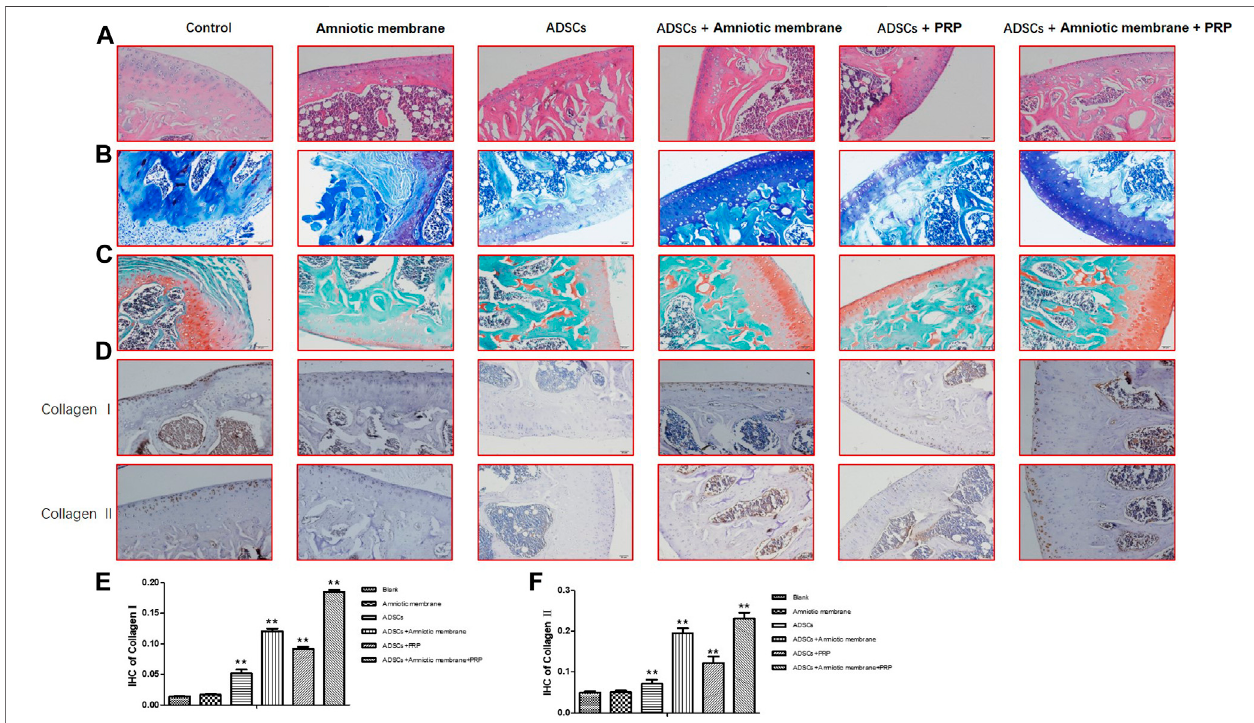
FIGURE 6 | The combination of amniotic membrane and PRP scaffolds effectively induced the differentiation of ADSCs into cartilage. Three-month-old male New Zealand rabbits were used to establish an animal model of cartilage defect in the knee joint of rabbits. The model rabbits were divided into six groups, including control (PBS), ADSC, amniotic membrane, ADSC + amniotic membrane, ADSCs + PRP scaffolds, and ADSC + amniotic membrane scaffolds + PRP scaffolds were injected into the articular cartilage defect, respectively. Five rabbits were included in every group. After 12 weeks of normal culture, the repaired tissue were analyzedbybiochemicalstainingforallsixgroupofanimals. (A) HEstainingshowedthattheintegrityofcartilagelayerwashigherinthePRPgroup,andthecartilagelayer in amniotic membrane group and amniotic membrane + PRP group was basically restored; the bone formation area was enlarged. Compared with control and ADSC alone,thecontentoftrabecularboneexhibitedsigni fi cantincreaseinamnioticmembrane+ADSC,PRP+ADSC,andADSC+PRP+amnioticmembranegroups. n (cid:2) 4. (B) Toluidine blue stainingshowed thatmembrane +ADSCsand ADSC +PRP +amniotic membranegroups showed deeper and more uniformstaining. Thesurface of cartilagelayerwassmoothandthecellswerearrangedorderly. n (cid:2) 3. (C) Theresultsofsaffronstainingshowedthatthedegreeofcartilagedamageineachgroupwasin orderfromlighttoheavy:ADSC+amnioticmembrane+PRPscaffoldsgroup > amnioticmembrane +ADSC > PRP+ADSC > ADSC > amnioticmembrane and control group. (D) IHCstainingresultsshowedthatthecontentofCollageIandCollageIIproteinsinthemembrane+ADSCandADSC+PRP+amnioticmembranegroupswere signi fi cantly increased compared with the other four groups, and the signals in the control group and amniotic membrane group were the least. Three sections were